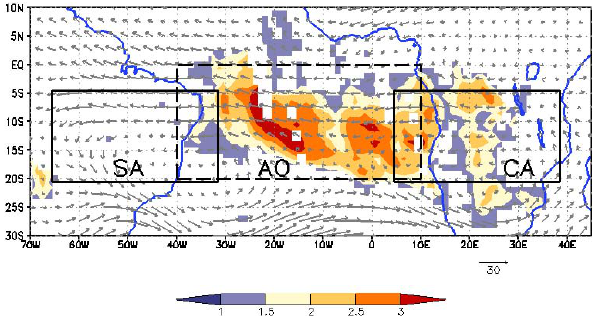
Fig. 1. Spatial distribution of the OMI Aerosol Index on 7 Septem- ber 2008. Arrows indicate the prevailing NCEP 700hPa wind field. Boxes indicate regions of analysis in South America (SA), Central Africa (CA), and Atlantic Ocean